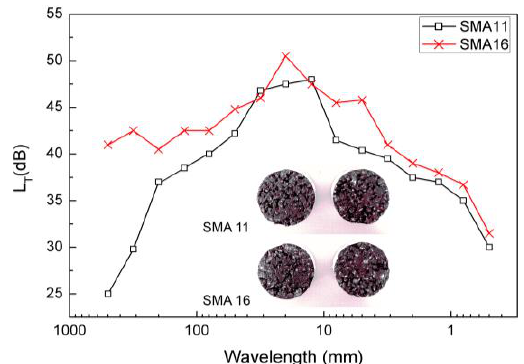
Figure 6. Texture spectra L T calculated from surface profile measurements and a detail of the studied bituminous mixture types SMA11 and SMA16.